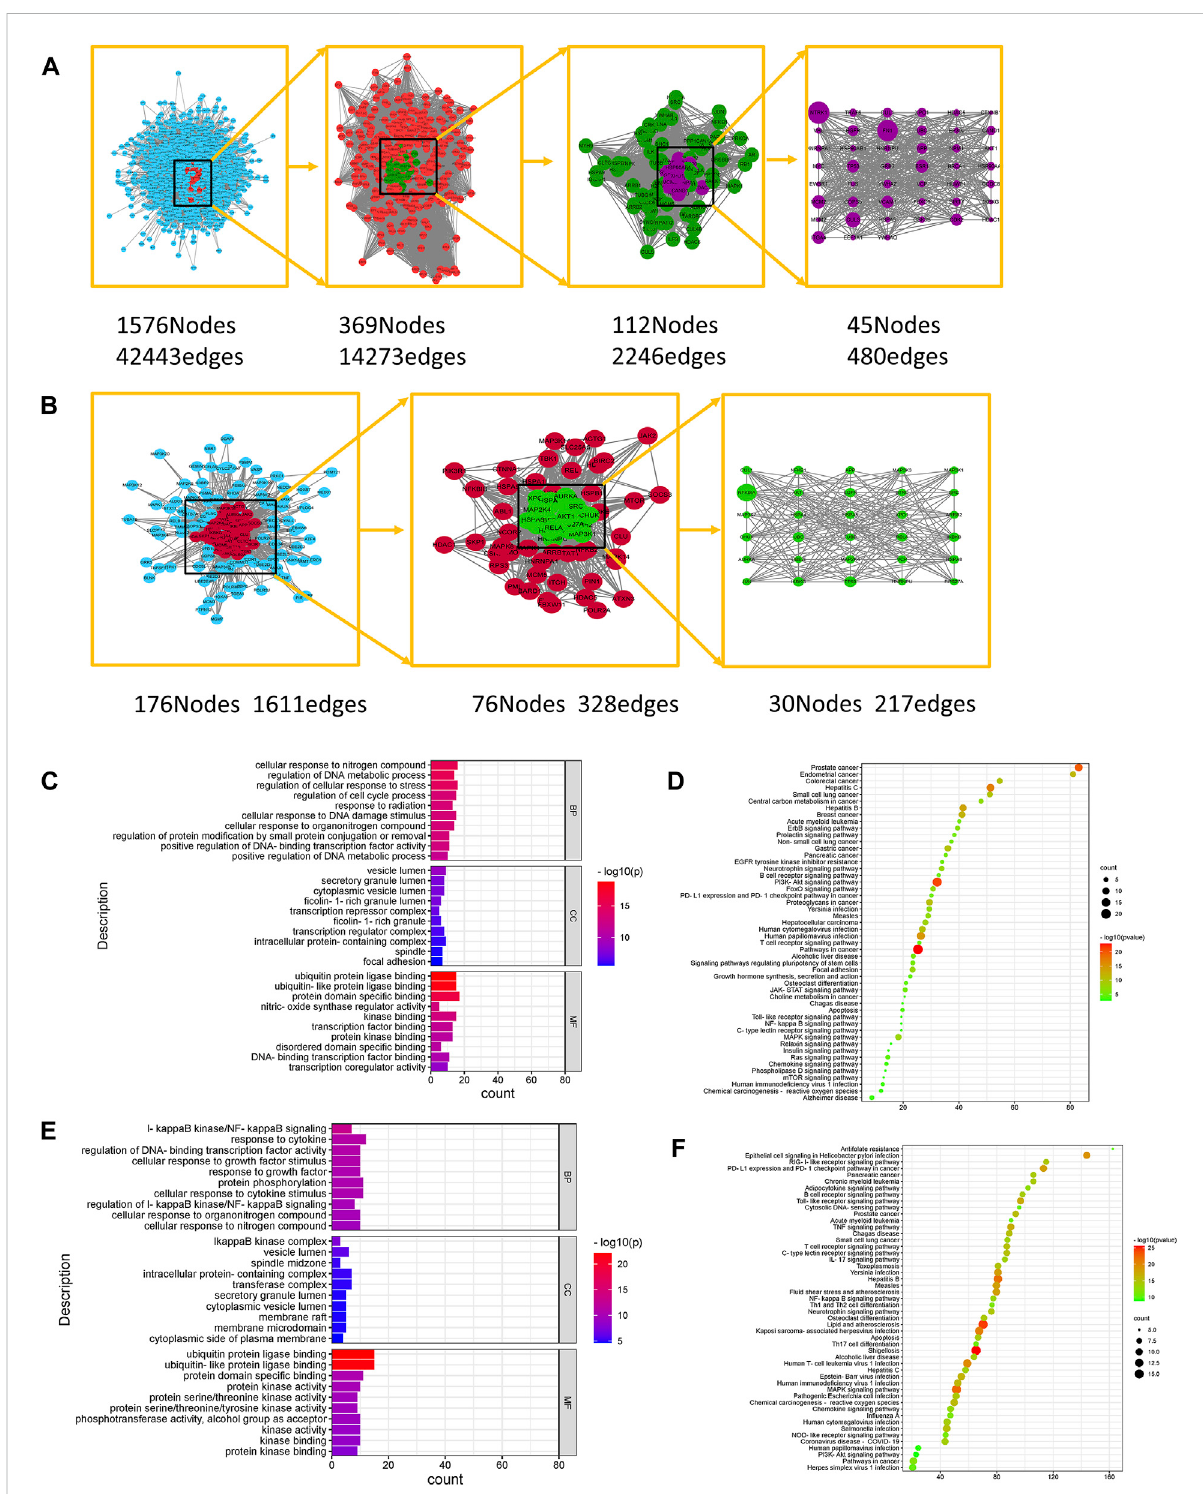
FIGURE 1 Network Pharmacological Analysis of Ginsenoside Rb1 and CK. (A) Topological network of key targets of ginsenoside Rb1 in the treatment of gastric cancer. (B) Topological network of key targets of ginsenoside CK in the treatment of gastric cancer. (C) GO biological function enrichment analysis of key targets of ginsenoside Rb1 in the treatment of gastric cancer. (D) KEGG pathway enrichment analysis of key targets of ginsenoside Rb1inthetreatmentofgastriccancer. (E) GObiologicalfunctionenrichmentanalysisofkeytargetsofginsenosideCKinthetreatmentofgastric cancer. (F) KEGG pathway enrichment analysis of key targets of ginsenoside CK in the treatment of gastric